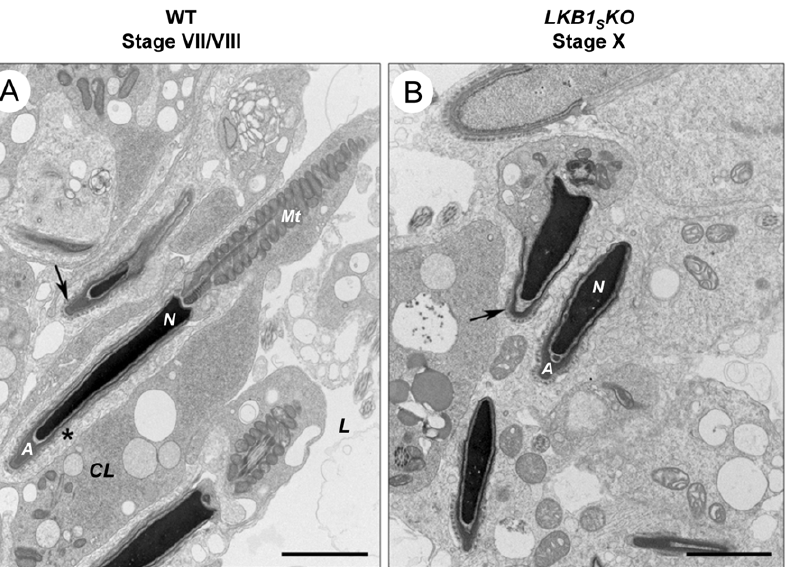
Figure 6. TEM images of cell junctions between sertoli cells and spermatids. A ) Elongated spermatids are shown around the lumen from a wild-type stage VII tubule before spermiation. The residual spermatid cytoplasm can be seen around the spermatid nucleus (N) as a cytoplasmic lobe (CL) . Although the actin bundles of ectoplasmic specialisations are still visible around some spermatids ( arrow ), they are beginning to break down around others as indicated by an asterisk . Mitochondria aligned along the spermatozoan flagellum are labelled (Mt) . Spermatid acrosomes (A) and the tubule lumen (L) are indicated. B) Elongated spermatids are shown around the lumen from a stage X LKB1 S KO tubule. These spermatids would normally have been released at stage VIII. Areas of ectoplasmic specialisations are still visible around the retained spermatid heads as indicated by an arrow , (scale bar =2 m m).